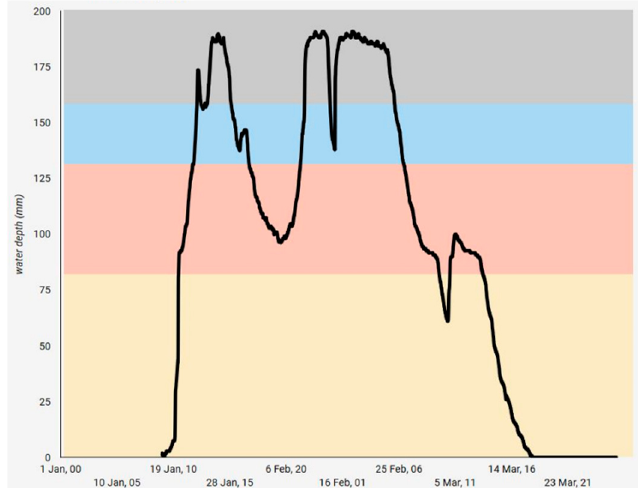
Figure 8. Daily water height monitored in a bay of a rice farm obtained from the multisensor capacitance probes.